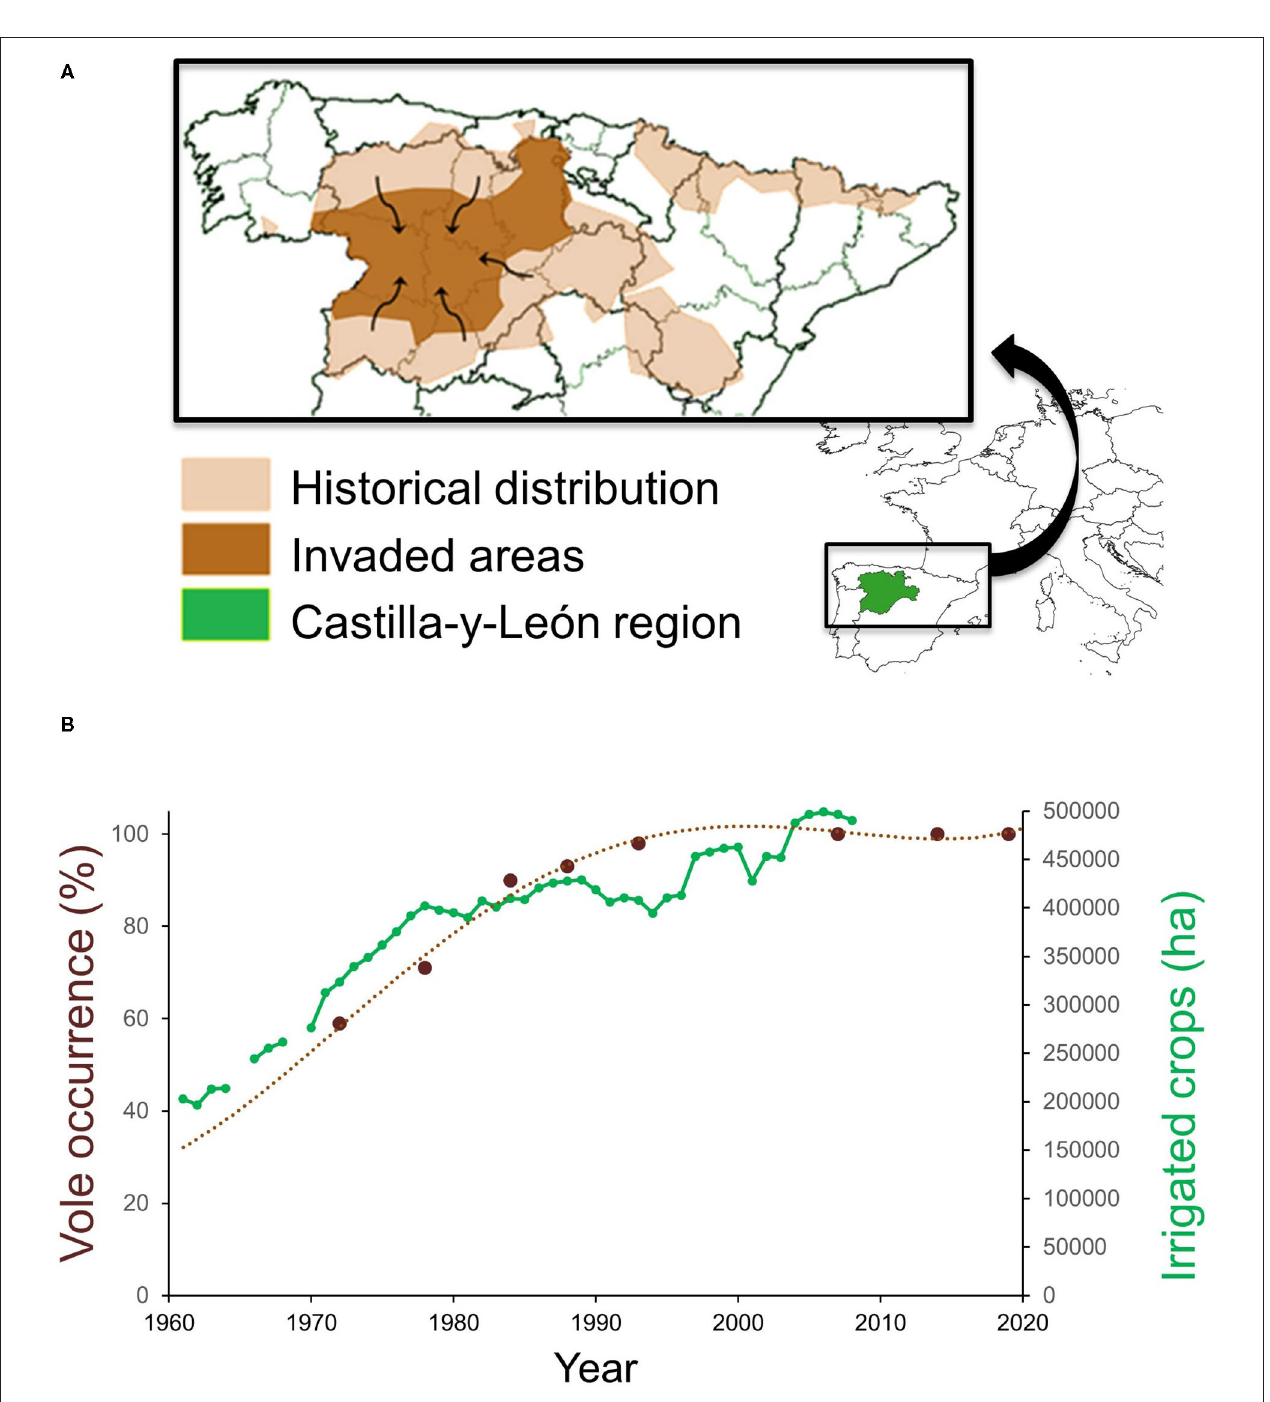
FIGURE 1 | (A) Map of NW Spain showing the historical distribution and area invaded by common voles during the 1970–90s, and (B) temporal association between vole occurrence (percentage of agricultural counties with vole presence) and the extent of irrigated crops planted in the Castilla-y-León region, NW Spain. Adapted from Jareño et al. (55) and Luque-Larena et al.